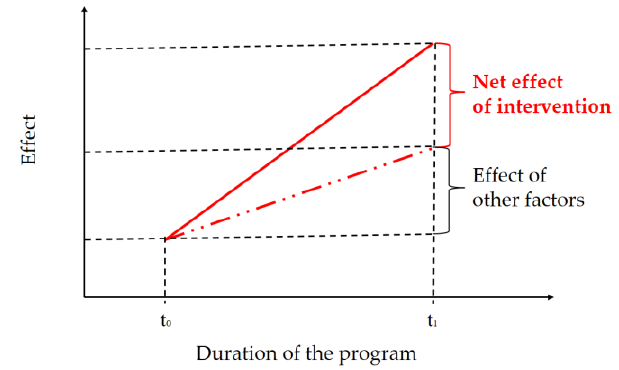
Figure 1. Determining the net effect of Common Agricultural Policy (CAP) pro-investment measures. Source: own study.